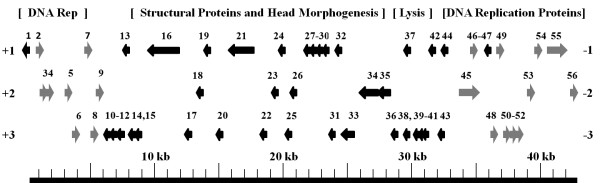
Schematic representation of the genome sequence of bacteriophage eiAU showing its overall genomic organization. The ORFs are numbered consecutively (see Table 1) and are represented by arrows based on the direction of transcription. The numbers +1, +2, +3 represent corresponding reading frames.